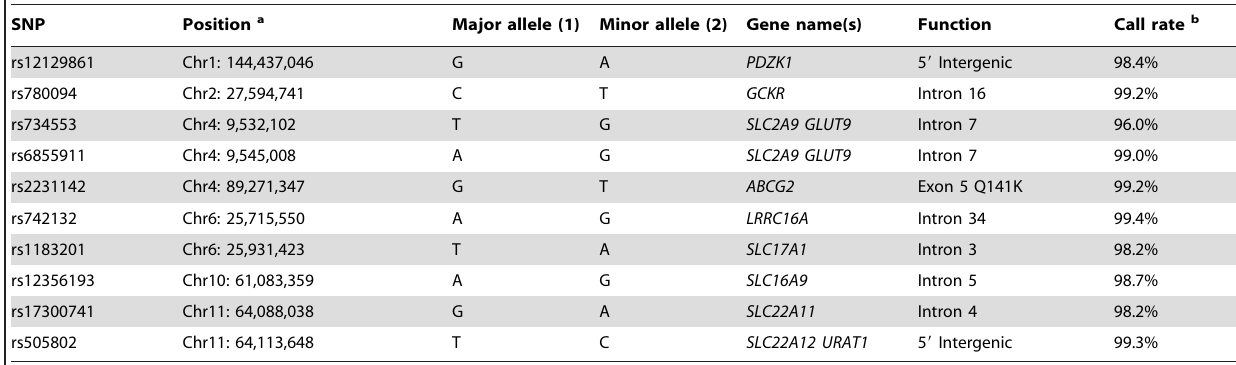
Table 3. SNP marker used in analysis.